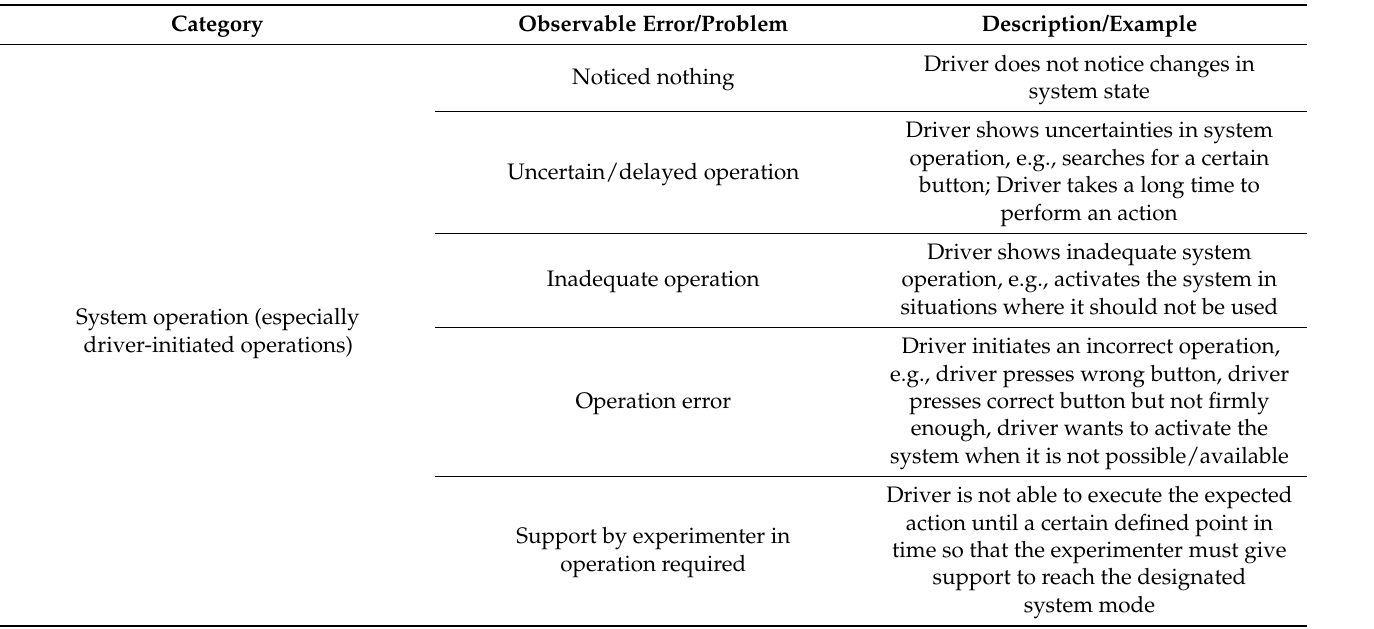
Table 1. Error definitions for observation